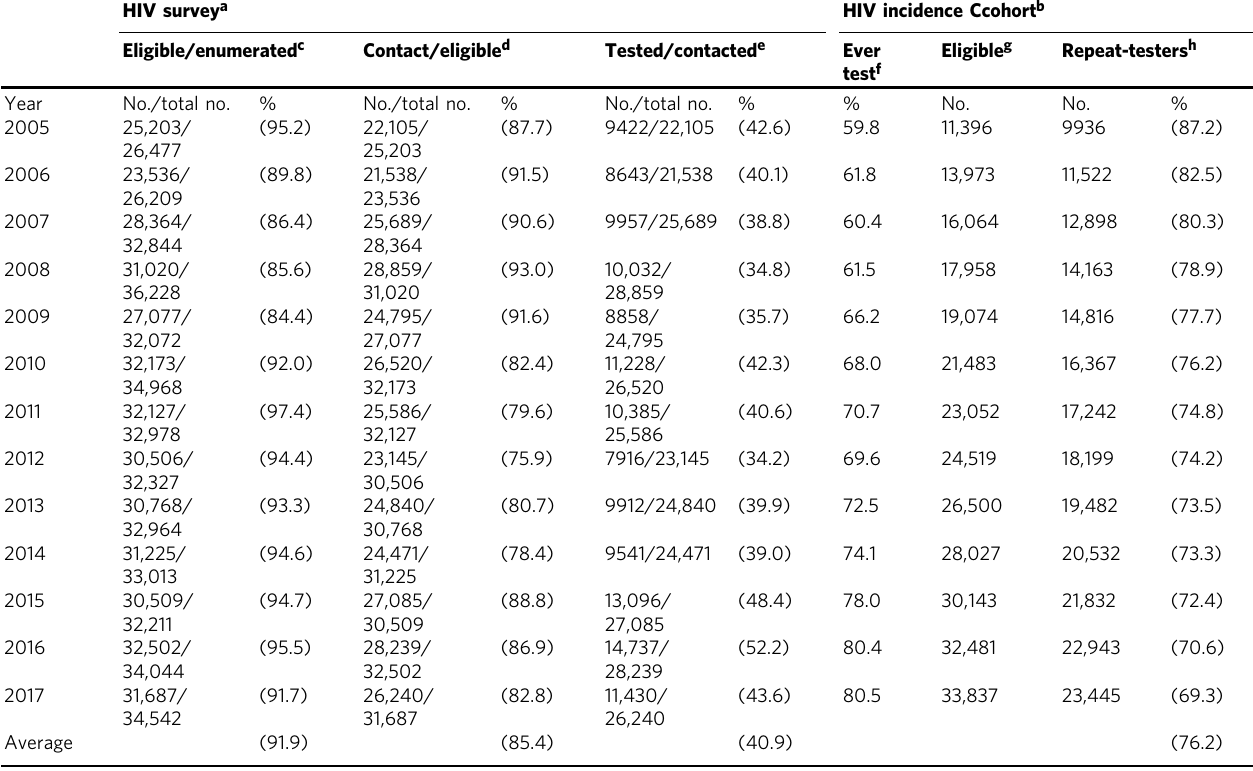
Table 1 Summary of testing participation in the HIV survey and HIV incidence